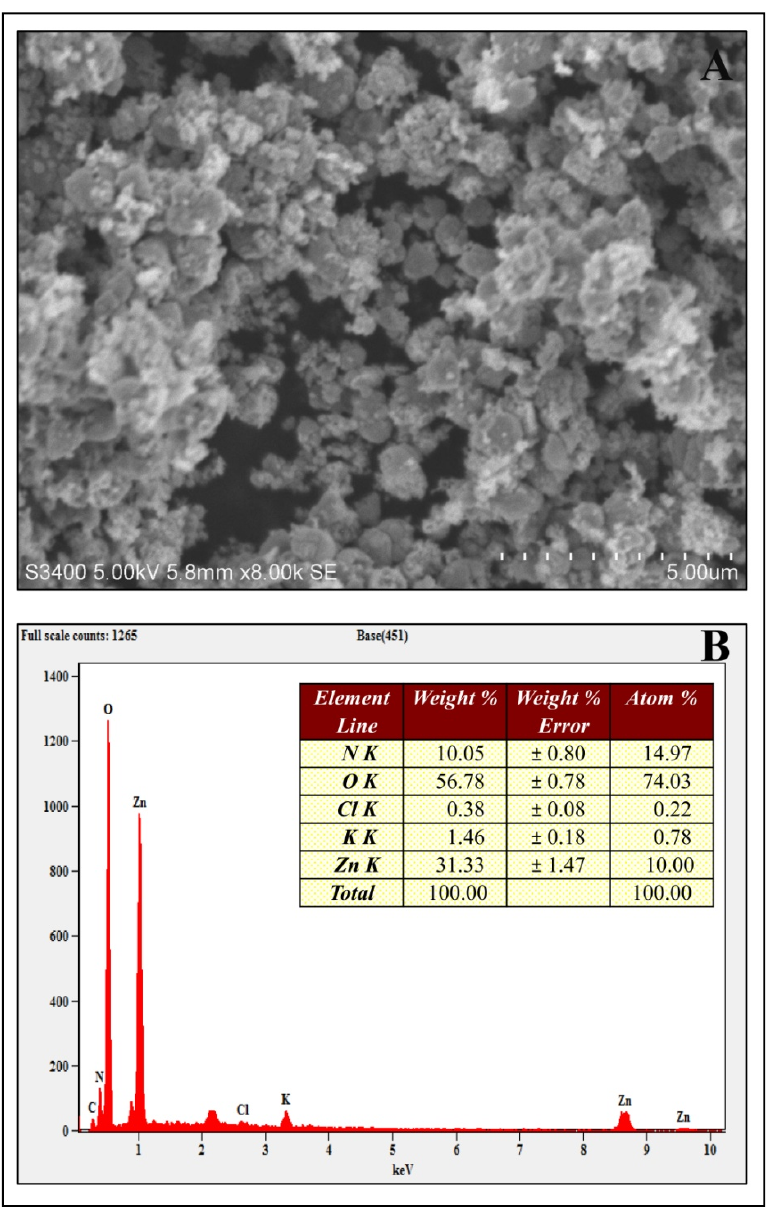
Figure 4. Scanning Electron Micrograph ( A ) and Energy Dispersive Spectra ( B ) of phyto-fabricated Figure ZnO-NPs.